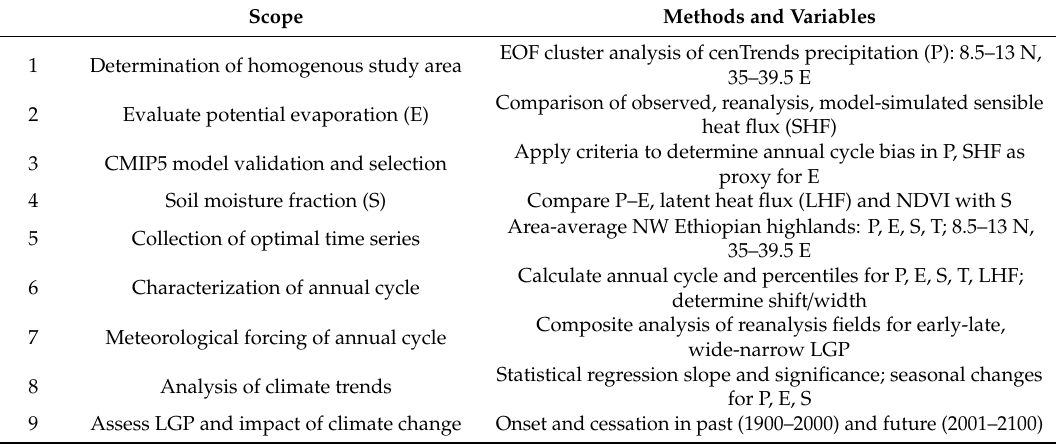
Table 1. Sequence of methods applied. CMIP5: Coupled Model Intercomparsion Project. Scope Methods and